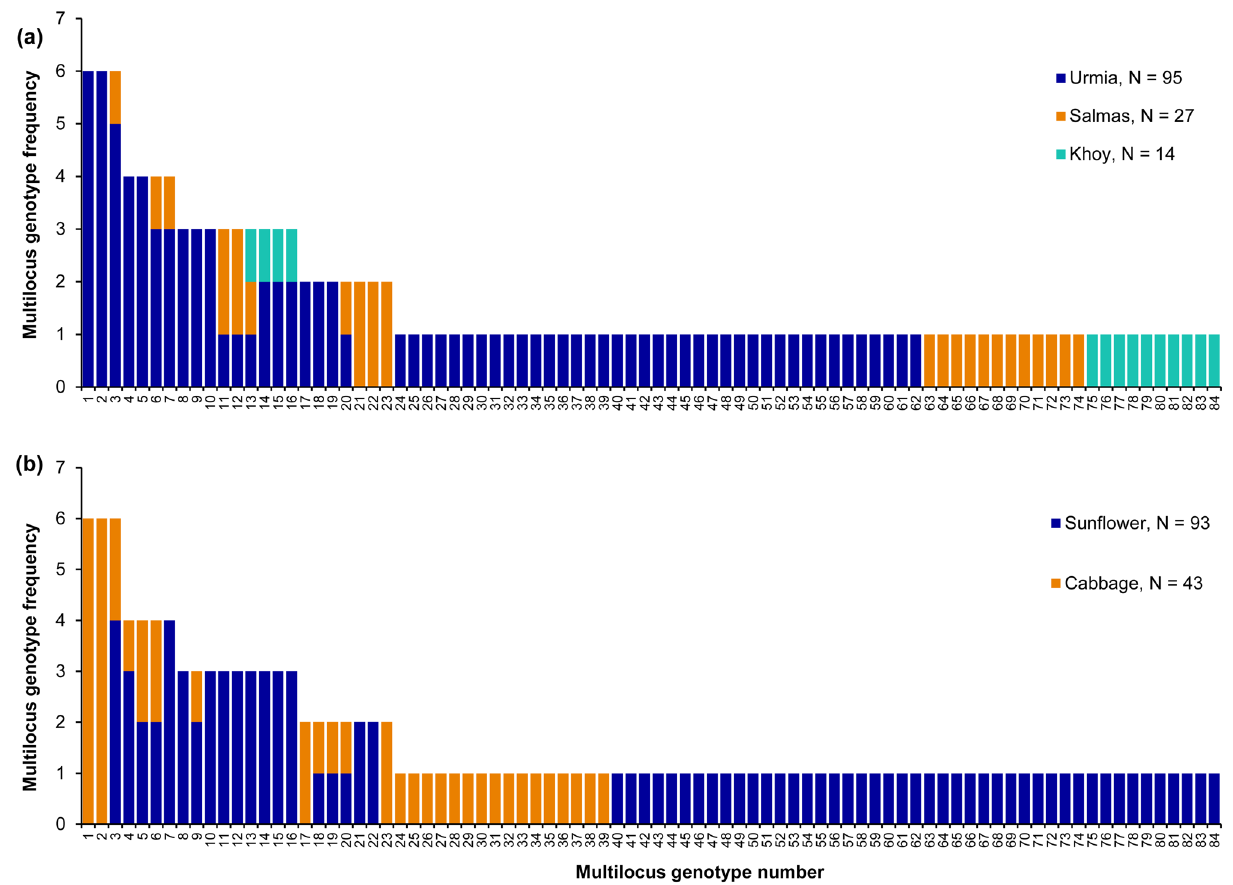
Figure 1. Frequency of ISSR multilocus genotypes (MLGs) for 136 isolates of Sclerotinia sclerotiorum from geographic ( a ) and host ( b ) populations in West Azarbaijan province of